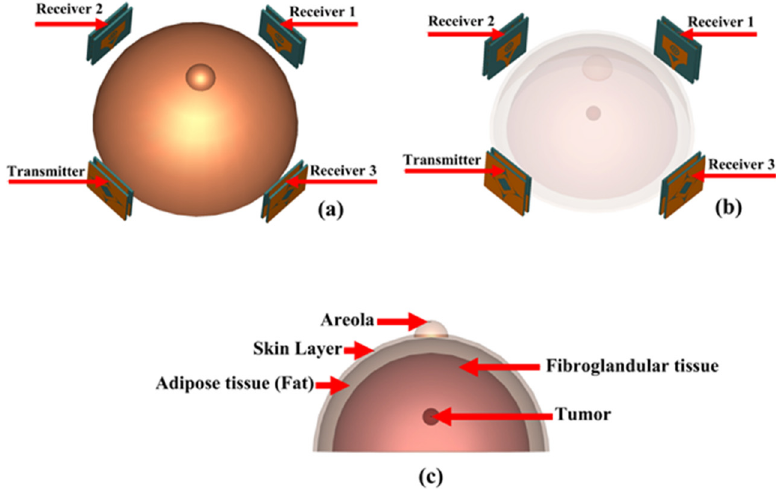
Figure 14. ( a ) and ( b ) simulation setup for MWI, ( c ) breast phantom. Table 2. The dielectric properties of the human breast tissues with tumor and malignant cells.